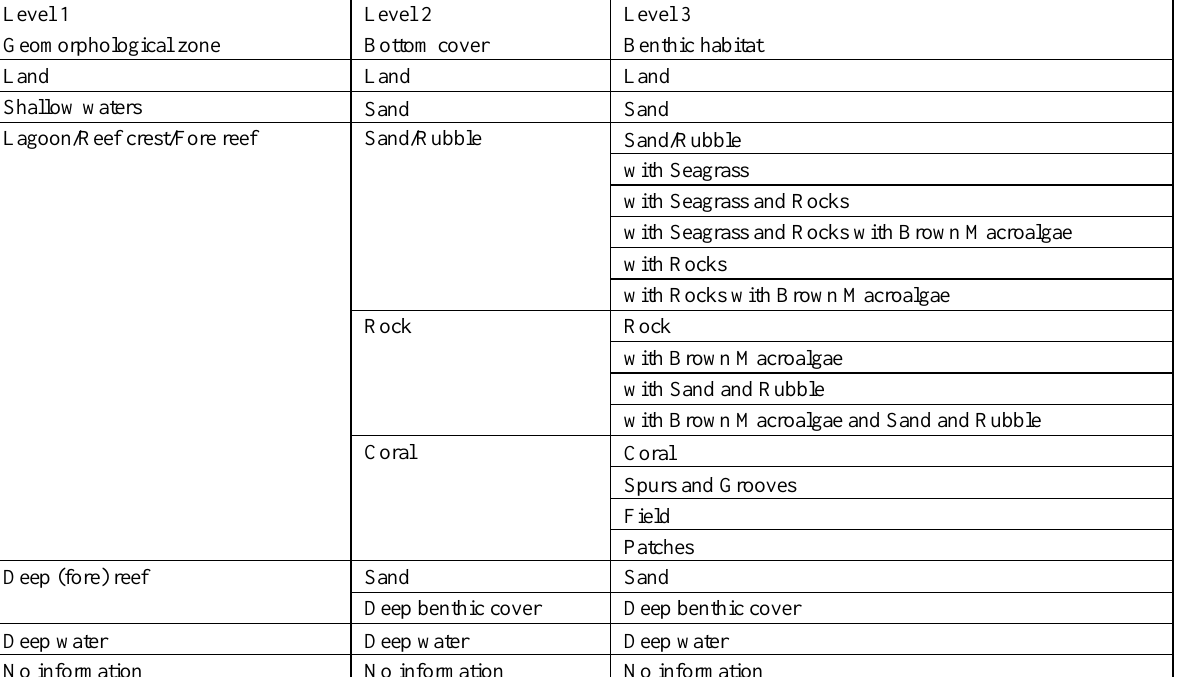
Figure 2. Bottom cover (L2) classes distribution. Locations are listed according to their N-S distribution.